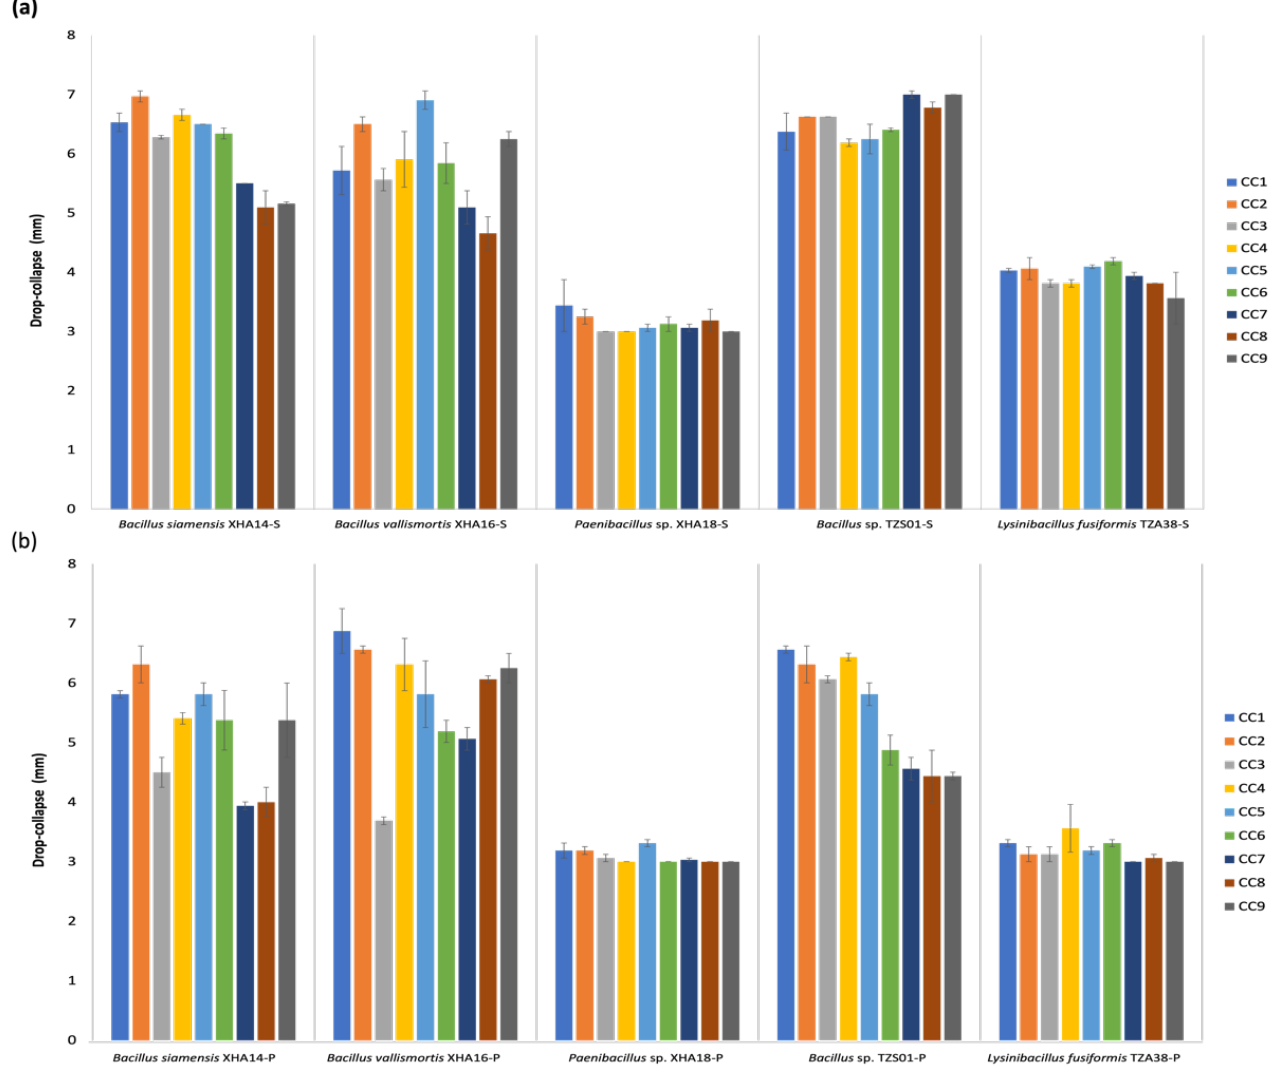
Figure 5. Optimization of culture conditions for biosurfactant activity, in sessile ( a ) and planktonic ( b ) systems of halotolerant bacteria.